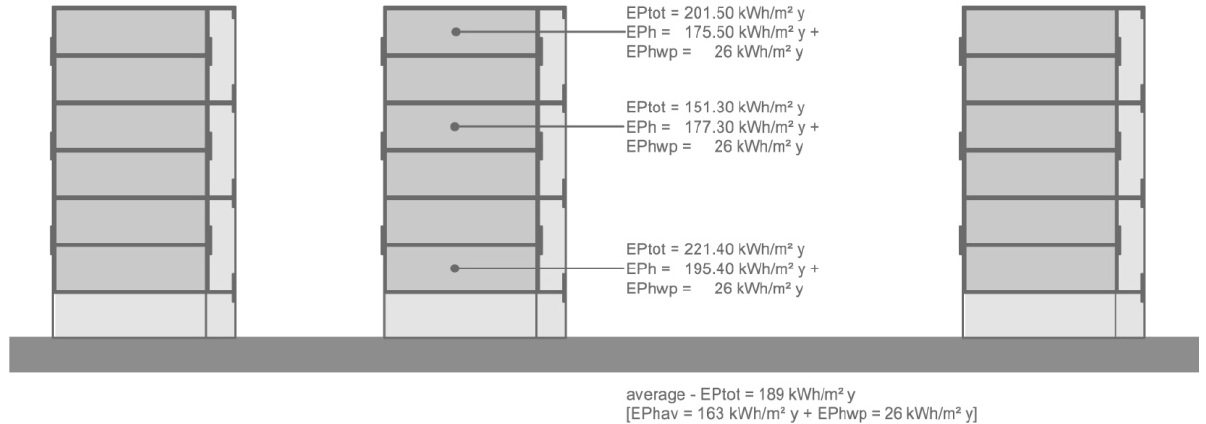
Figure 2. The Energy Performance index (EP) of the three identified